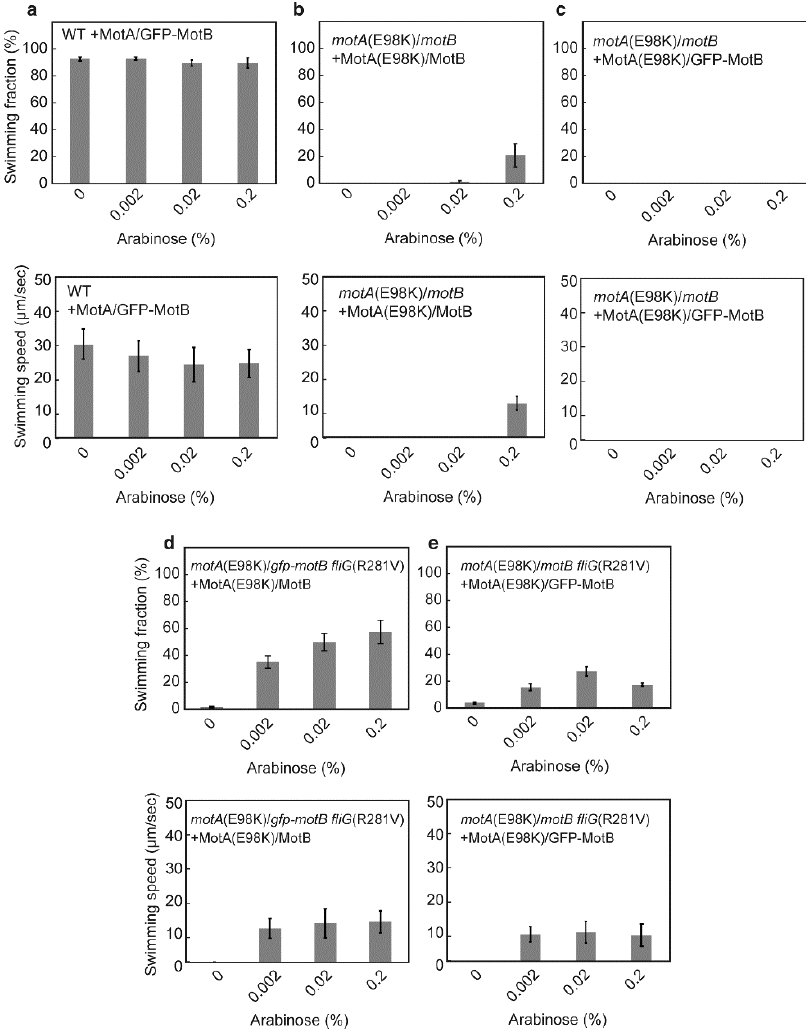
Figure 4. Multicopy effect of MotA/MotB mutants on swimming motility in liquids. The fraction and speed of free-swimming cells were measured for SJW1103 carrying pYVM042 ( a ), YVM47 carrying pYC20(E98K) ( b ), or pYVM042(E98K) ( c ), YVM036 carrying pYC20(E98K) ( d ), and YVM048 carrying pYVM042(E98K) ( e ). Swimming fraction is the fraction of swimming cells. Swimming speed is the average speed of more than 30 cells, and error bars are the standard deviations. If the fraction of motile cells was less than 5% of the total cells, the swimming speed is zero. The cells were incubated at 30 °C for 5 h in LB with 0.2, 0.02, or 0.002% arabinose. Measurements were recorded at around 23 °C.